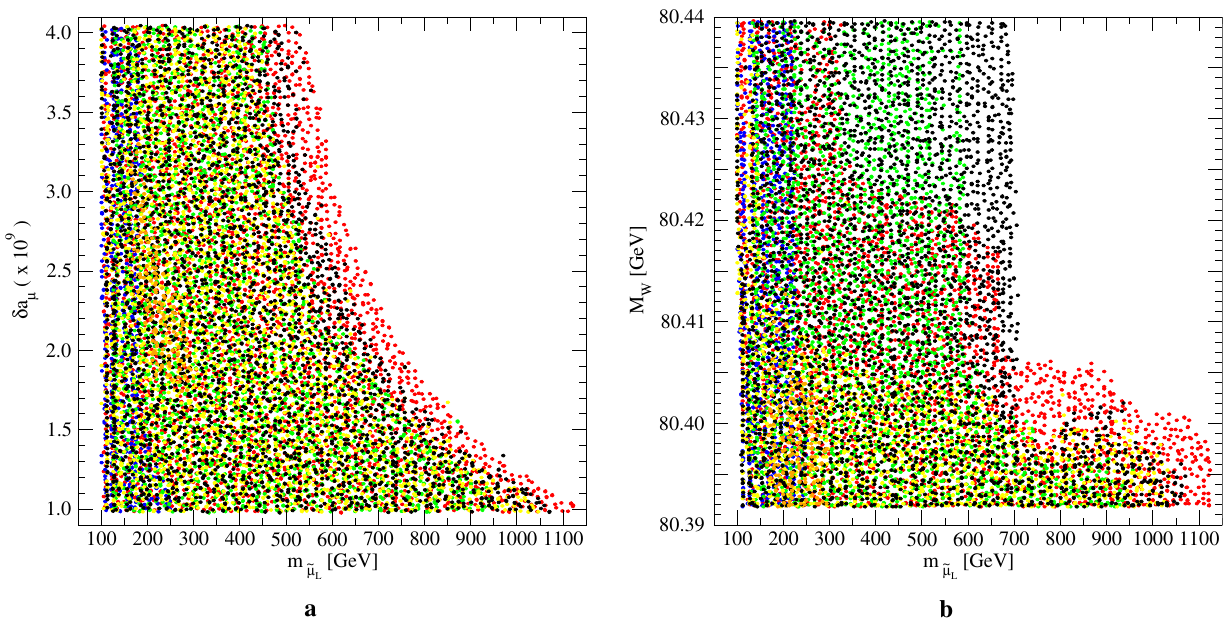
Fig. 2 δ a μ (left) and M W (right) as function of the left-handed smuon mass m ˜ μ χ ± : blue for (cid:14) + ˜ ν (cid:14) , red for τ + ˜ ν τ , green for χ 0 1